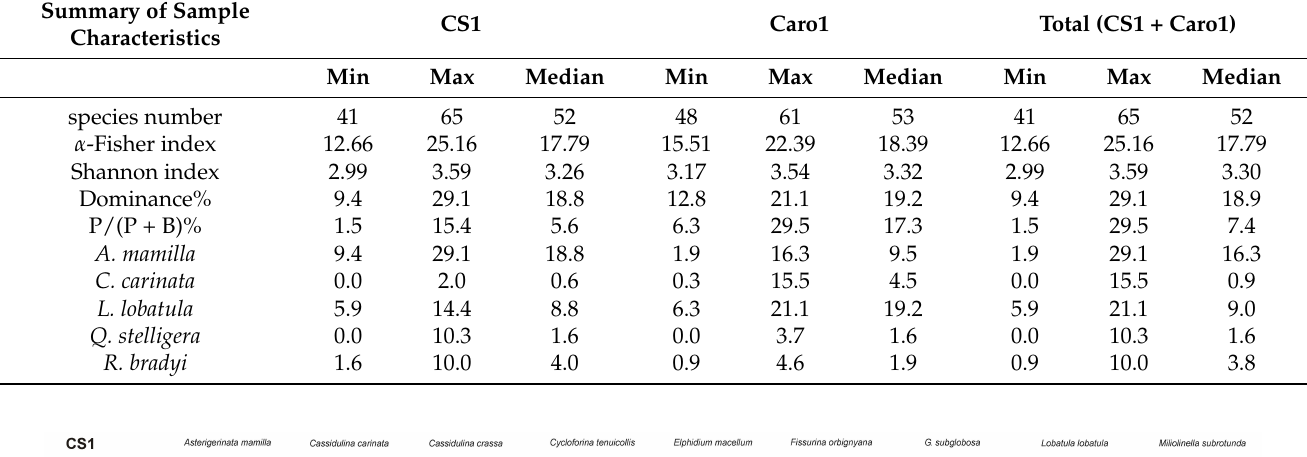
Table 2. Range and median values of species number, α -Fisher index, Shannon index, percentage of dominance, P/(P + B)% and the five more abundant species (>10%) calculated for each core separately and globally. Summary of Sample